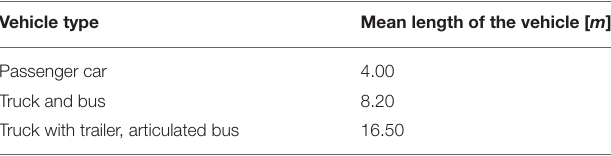
TABLE 6 | The lengths of the selected types of